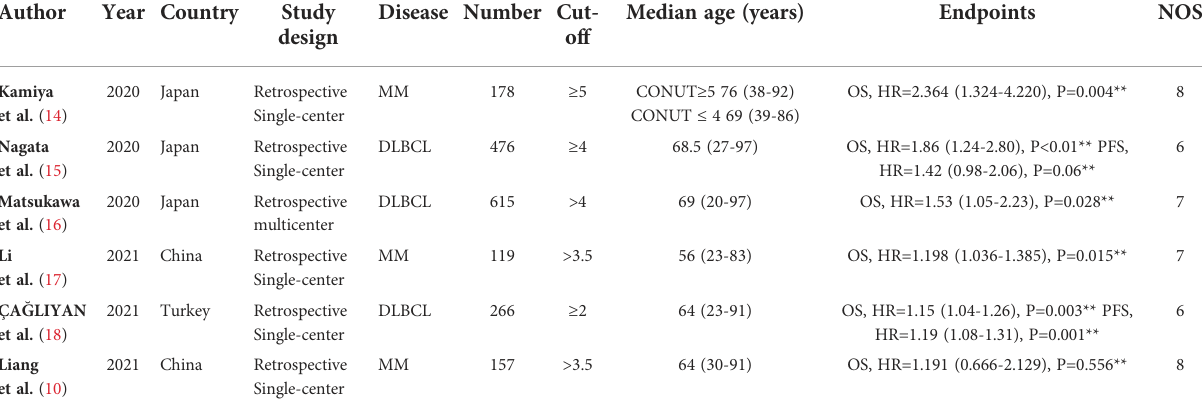
TABLE 2 The characteristics of the included studies.